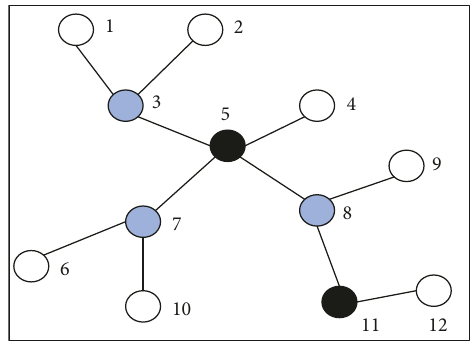
Figure 7: The constructed